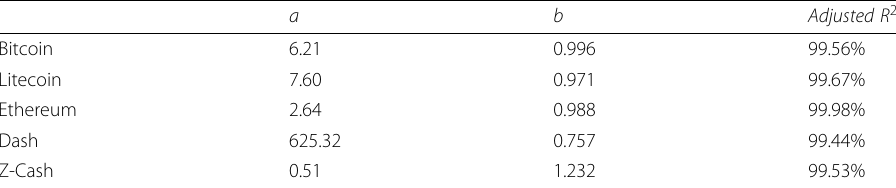
Table 4 Estimated parameters for the best-fitted curve on the chart of the number of edges by the number of nodes in CMTG graph a b Adjusted R 2 Bitcoin